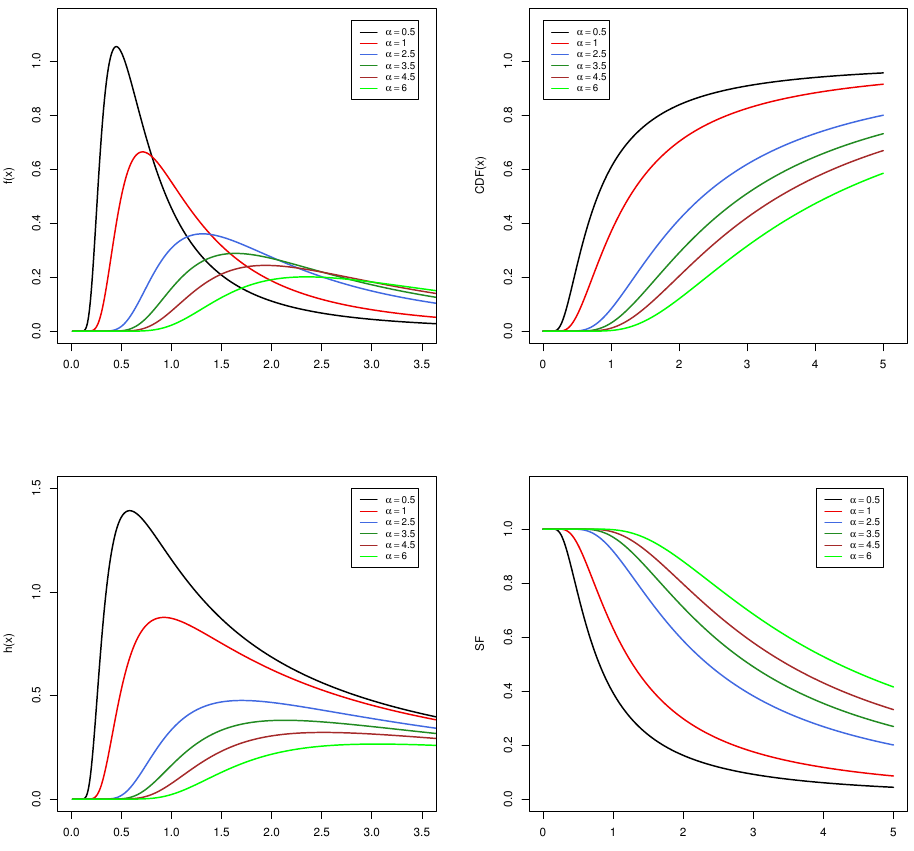
Figure 1. Plots of PDF, CDF, HF and SF of IWD for various values of α with β = 1. The Bayesian method in statistical inference depends upon the choice of prior dis- tribution and loss function. Many loss functions, such as squared error (SE) loss, linear exponential (LINEX) loss, generalized entropy loss, scaled square error (SSE) loss and precautionary loss functions, have been used to develop the Bayesian method estimates. The SE loss function is the most widely used loss function that can easily be justified based on the minimum variance unbiased estimation. The SE loss function is symmetric, and its disadvantage is placing equal weight on over- and underestimates of same magnitudes.